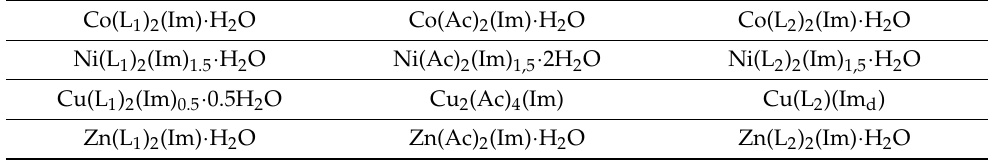
Table 1. Formulas of the synthesized M(II) formate and propionate complexes with imidazole and previously synthesized M(II) acetate complexes with imidazole